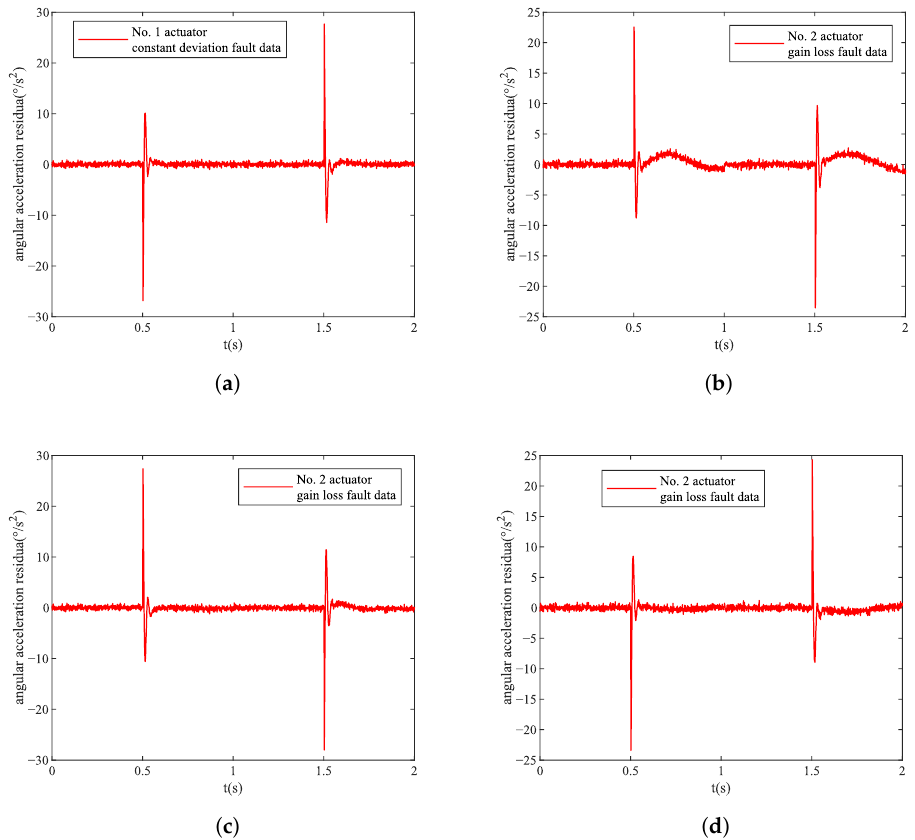
Figure 8. Actuator fault data. ( a ) No. 1 actuator constant deviation fault data. ( b ) No. 1 actuator gain